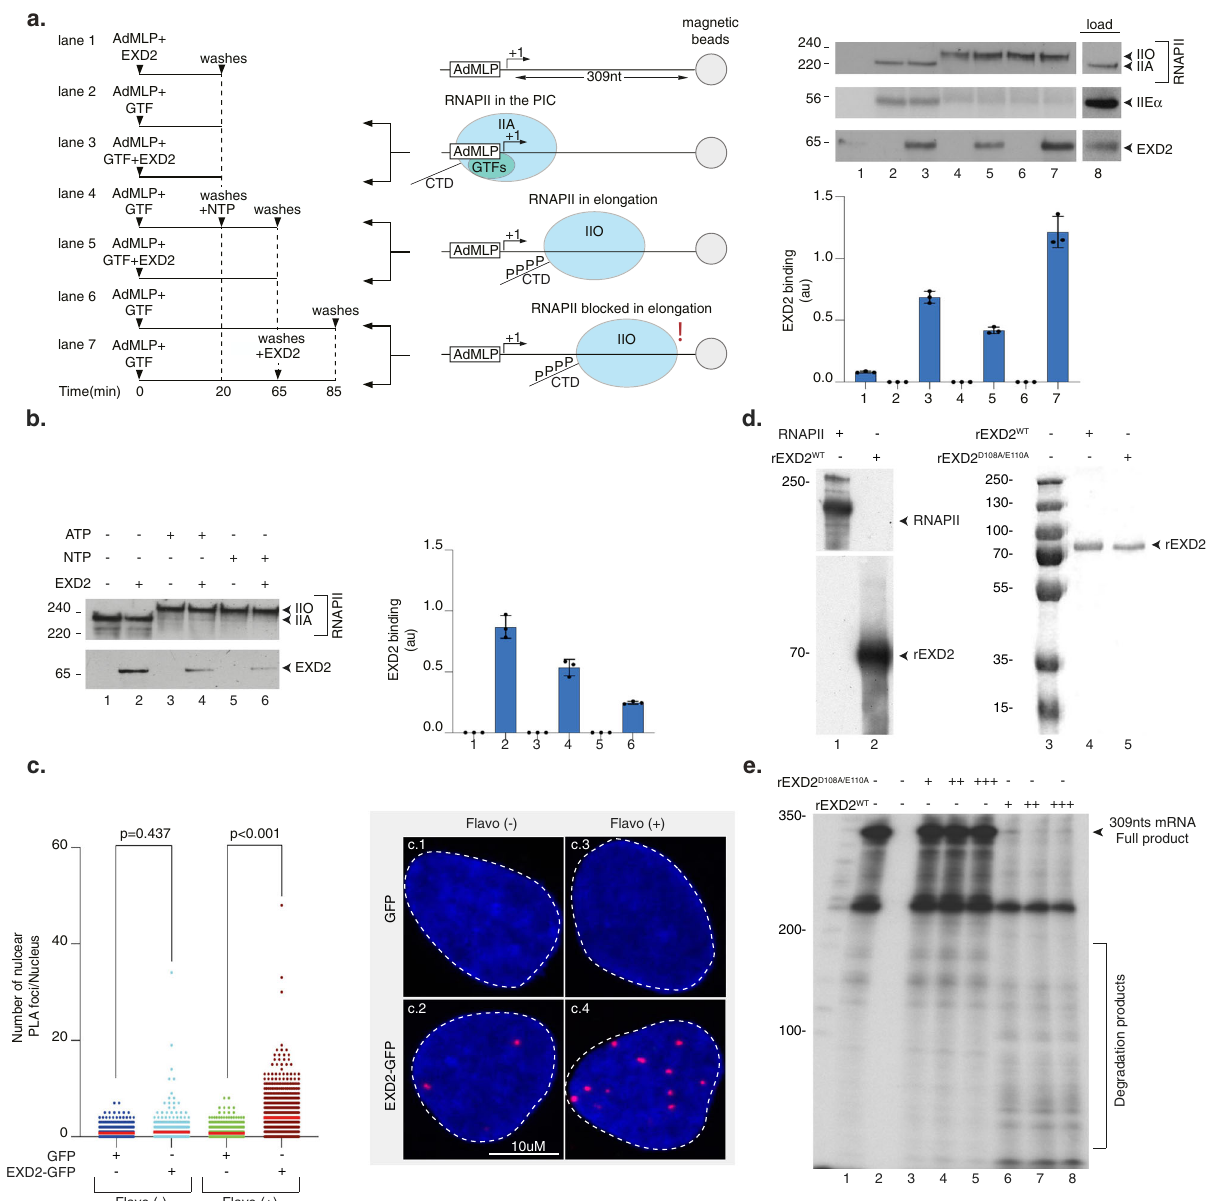
Fig. 6 | EXD2 preferentially interactswithRNAPII stoppedin elongation. a Left panel; biotinylated DNA template was bound to streptavidin magnetic beads and incubated for 20min with puri fi ed RNAPII and GTFs. After washes, NTPs were added to initiate RNAPII elongation for 45min. Middle panel; Three conditions were used: in the absence of NTPs where PIC is formed, in the presence of NTPs in which RNAPII is in elongation, and after the chase of NTPs in which RNAPII is blocked from elongating. Right panel; the binding of different factors was eval- uated by immunoblotting. The signals for rEXD2 were quanti fi ed and plotted in arbitrary units (au). The values are the means of three independent experiments (+/ − SD)(Technicaltriplicates).Molecularsizesareindicated(KDa).Sourcedataare provided as a Source Data fi le. b The biotinylated DNA template was bound to streptavidin magnetic beads and incubated for 20min with puri fi ed RNAPII and GTFswithorwithoutEXD2asindicated.Afterwashes,ATPorNTPswereaddedfor 45min. The binding of different factors was evaluated by immunoblotting and the signals for EXD2 were quanti fi ed and plotted in arbitrary units (au). The values are the means of three independent experiments (+/ − SD) (Technical triplicates).